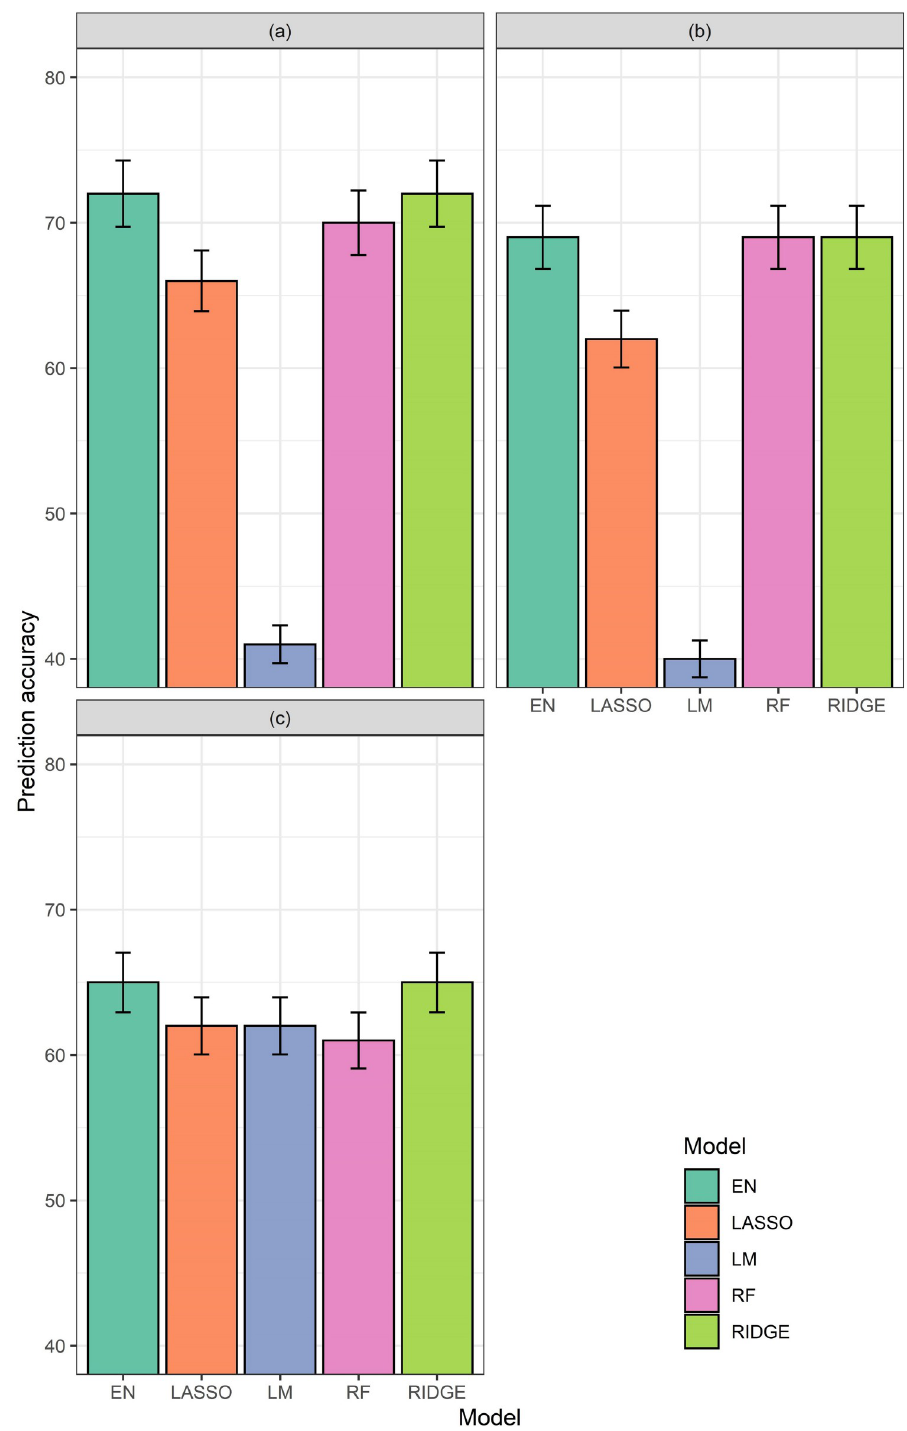
Fig 4. Accuracies generated by different models with different regressions from Group-I models. (a) Model-I-1: Time series VIs and time series CHM for the entire growing season, (b) Model-I-2: Time series VIs only for the entire growing season, and (c) Model-I-3: Time series CHM only for the entire growing season. Accuracies from elastic net (EN), lasso (Lasso), ridge (Ridge), and random forest (RF) models have been shown along the Y-axes.